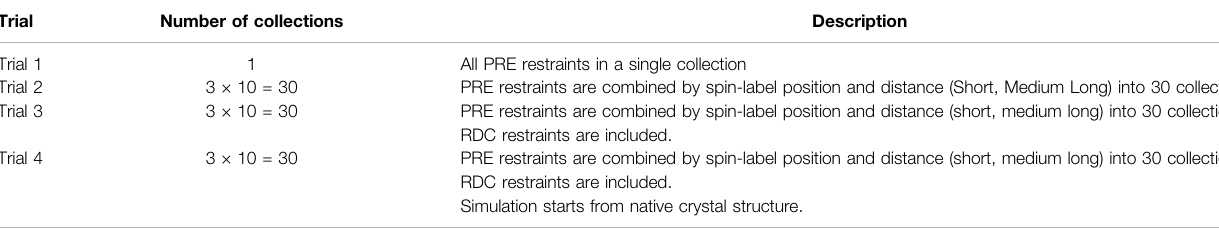
TABLE 2 | Grouping of restraints for simulations and description of individual trials.